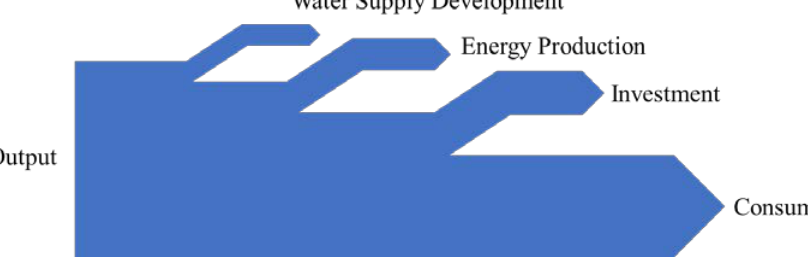
Figure 5. Goods allocation in the energy-water-economy sector of theANEMI3.